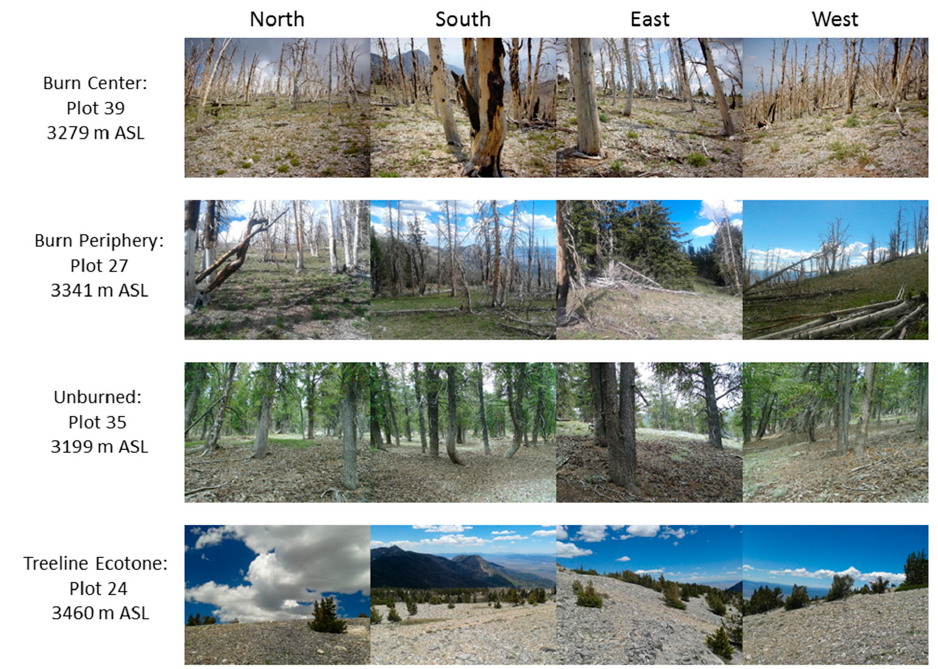
Figure 3. Photographs of four plots sampled during the 2012 and 2013 field seasons (see Figure 1 for plot locations). One photograph was taken for each cardinal direction (photo credits: M. Kilpatrick). The plots represent features of the study area (from top to bottom): center of the area burned in year 2000, edge of the burned area, outside the burned area, and near treeline (i.e., elevation ≥ 3350 m). All stems mapped at these plots were Pinus longaeva and Pinus flexilis (Figure 4). Table 2. Summary of regeneration counts (i.e., total seedlings and saplings) for plots inside (“Burned”) and outside (“Unburned”) the 2000 fire perimeter.